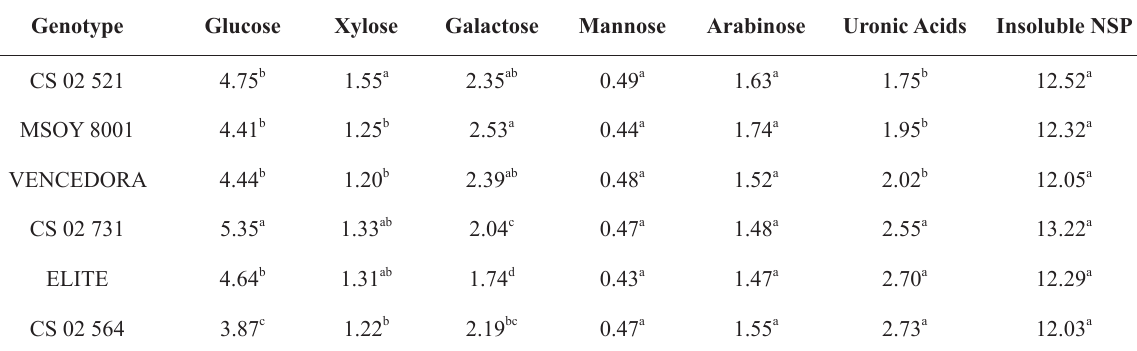
Mean concentrations of insoluble NSP and its constituent (monosaccharides and uronic acids) in six soybean genotypes, expressed in dry matter (g.100g -1 ).